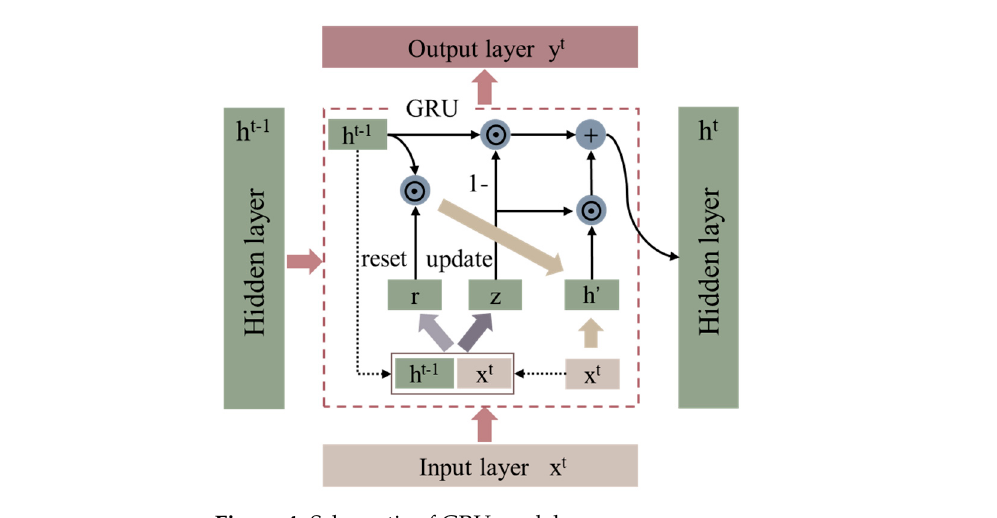
Table 2. Setting of GRU parameters.